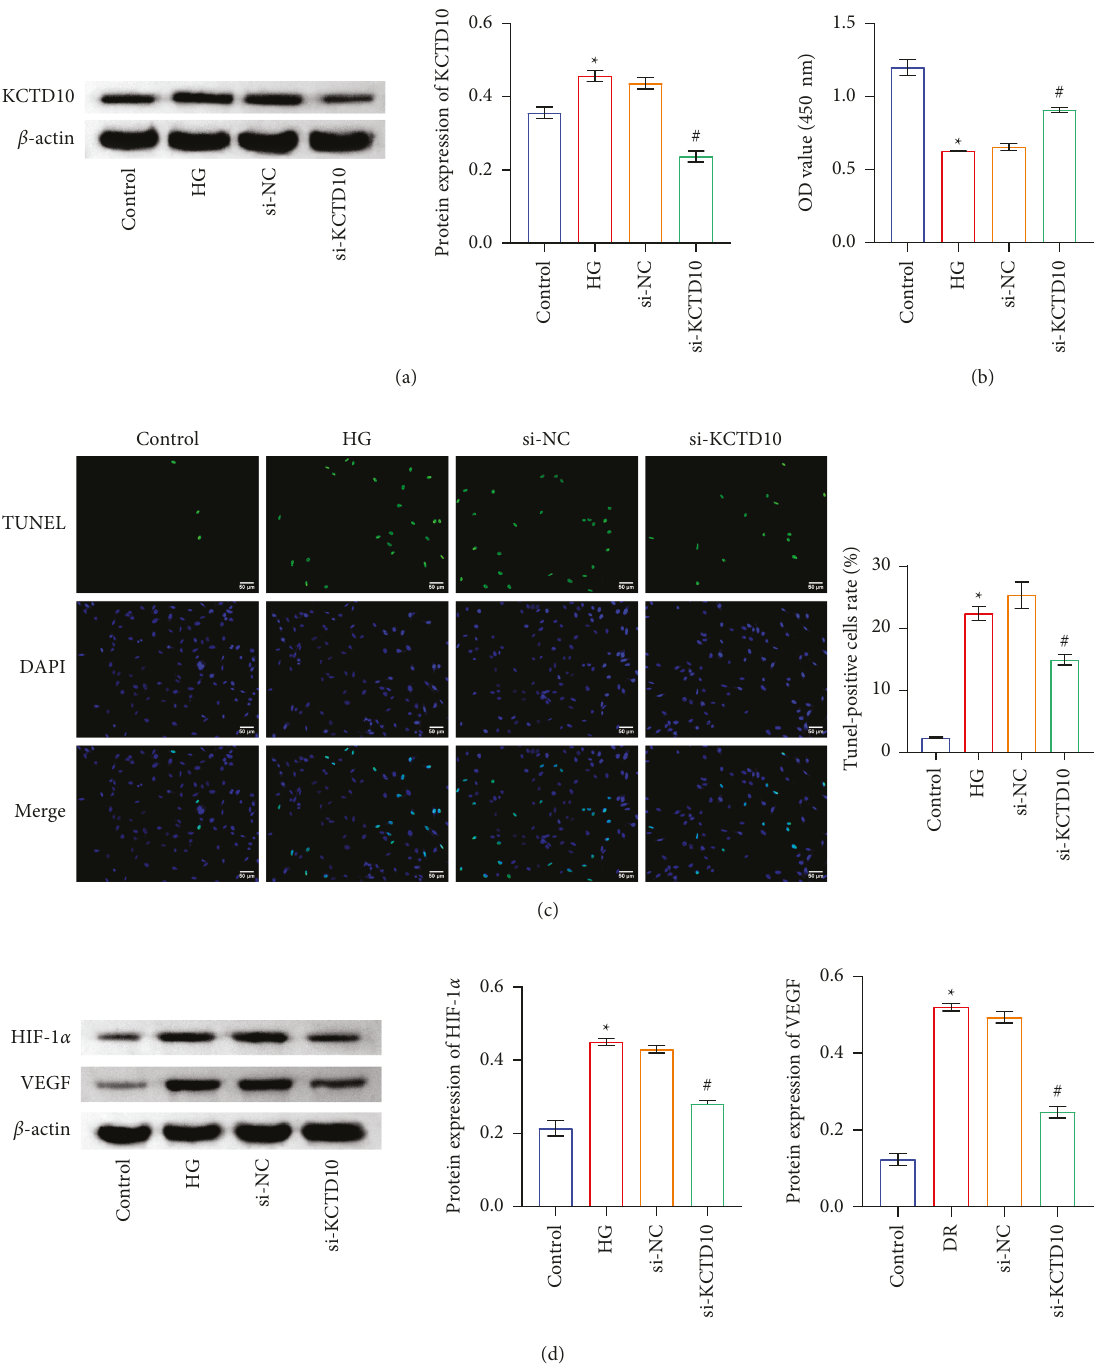
Figure 2: KCTD10 inhibition attenuated HG-induced ARPE-19 cell damage. (a) Western blot detection of KCTD10 protein expression. (b) CCK-8 assay detection of cell proliferation. (c) The cell apoptosis was observed by TUNEL staining. (d) Western blot detection of HIF-1 α and VEGF expression. ∗ P < 0 . 05 versus the control group. # P < 0 . 05, versus the si-KCTD10